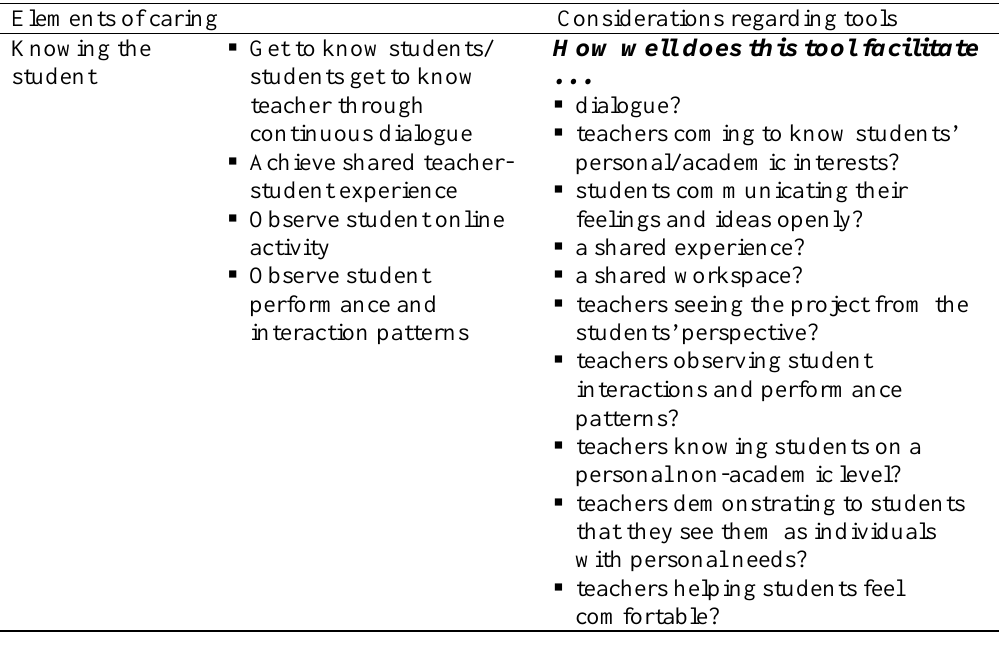
Table 1 Technology Choices for Understanding and Knowing the Student Elements of caring Considerations regarding